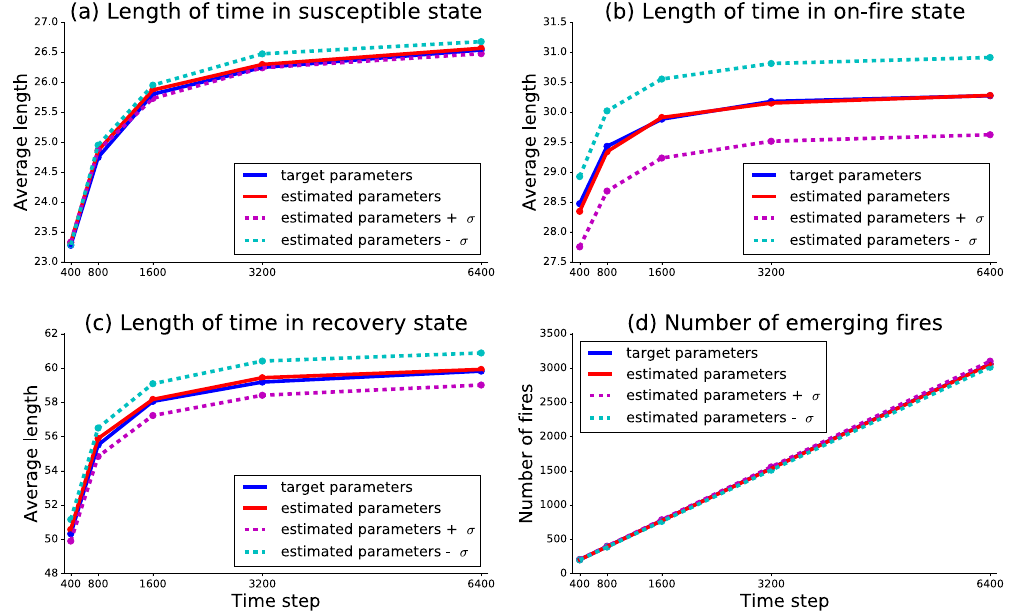
Figure 4. Impact of recovered parameter uncertainty on the prediction of model dynamics. The average length of time in each state is recorded for five time intervals: 400, 800, 1600, 3200 and 6400 time steps. The number of houses is 56. Using parameter values shown in Table 1, parameter recovery was run on 50 different historical datasets generated by simulations with different seeds for random number generator. ( a ) shows how long a house stays in the fully operational state which is determined by internal and external fire triggering processes. Since the effect of increasing α is reduced by the effect of decreasing β and vice versa, their combined effects is smaller than in the case of other parameters. ( b , c ) show the average length of time for the states of on-fire and recovery. Only one parameter determines the length of time so the gap is larger than ( a ) but still low. ( d ) shows the number of new fires during the simulation. All cases yield similar results.